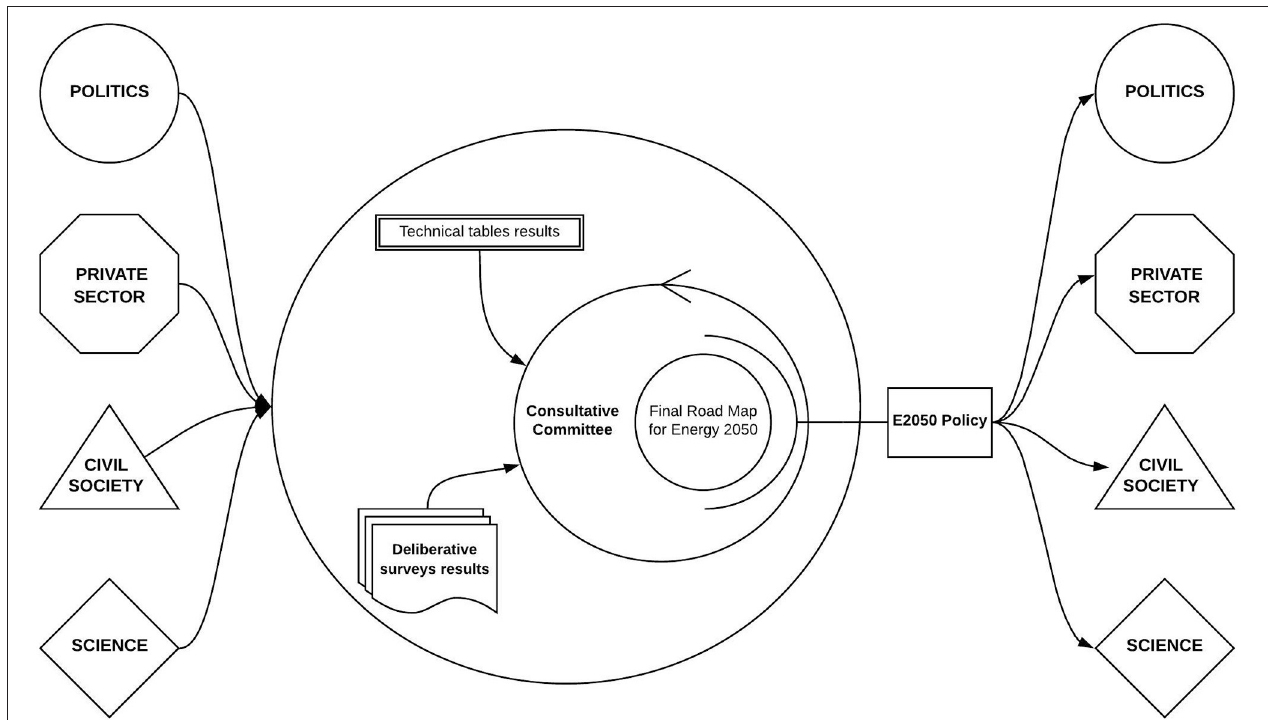
FIGURE 6 | E2050 as a boundary